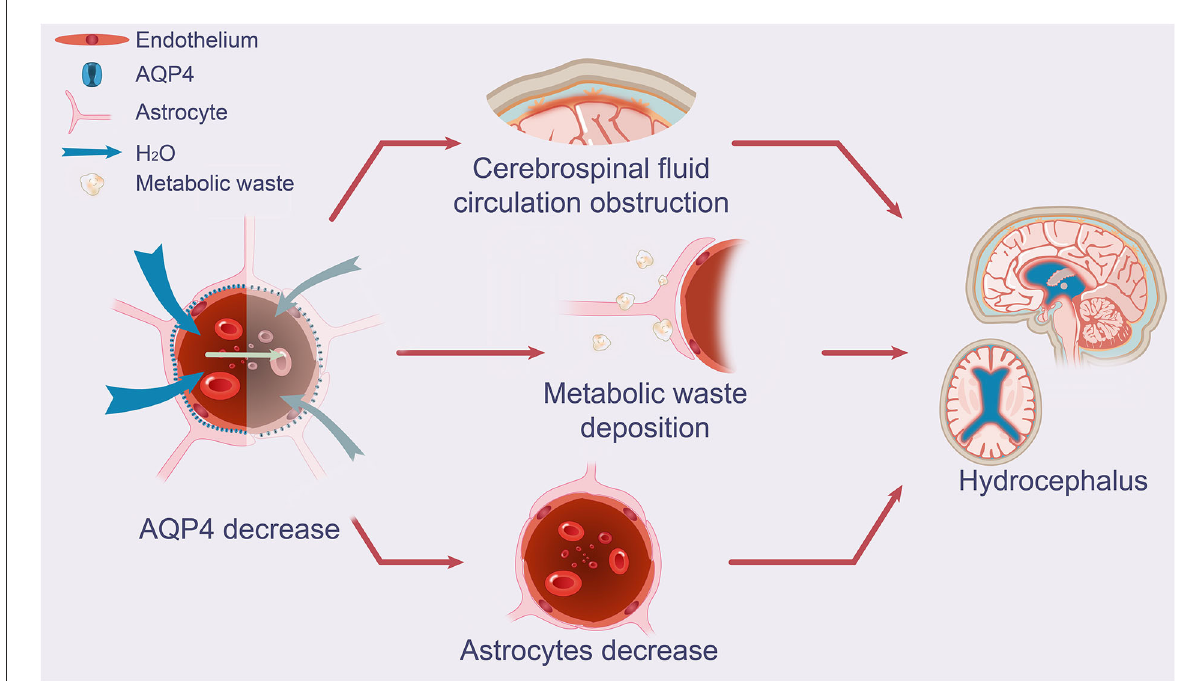
FIGURE2 Effect of AQP4 on potential glymphatic dysfunction and growth of astrocytes in iNPH. The schematic drawing demonstrates decreases in AQP4 and its function in iNPH, which leads to diminished CSF periarterial inflow, CSF-ISF exchange, and perivenous outflow of CSF mediated by AQP4 depolarization, as seen in patients with iNPH. Increased concentrations of neuronal metabolic waste products in the brain interstitial space result from the decreased exchange of CSF and ISF. A decrease in AQP4 in the end-feet of astrocytes near arteries was substantially associated with astrocyte growth and CSF circulation obstruction. AQP4, aquaporin 4; iNPH, idiopathic normal pressure hydrocephalus; CSF, cerebrospinal fluid; ISF, interstitial